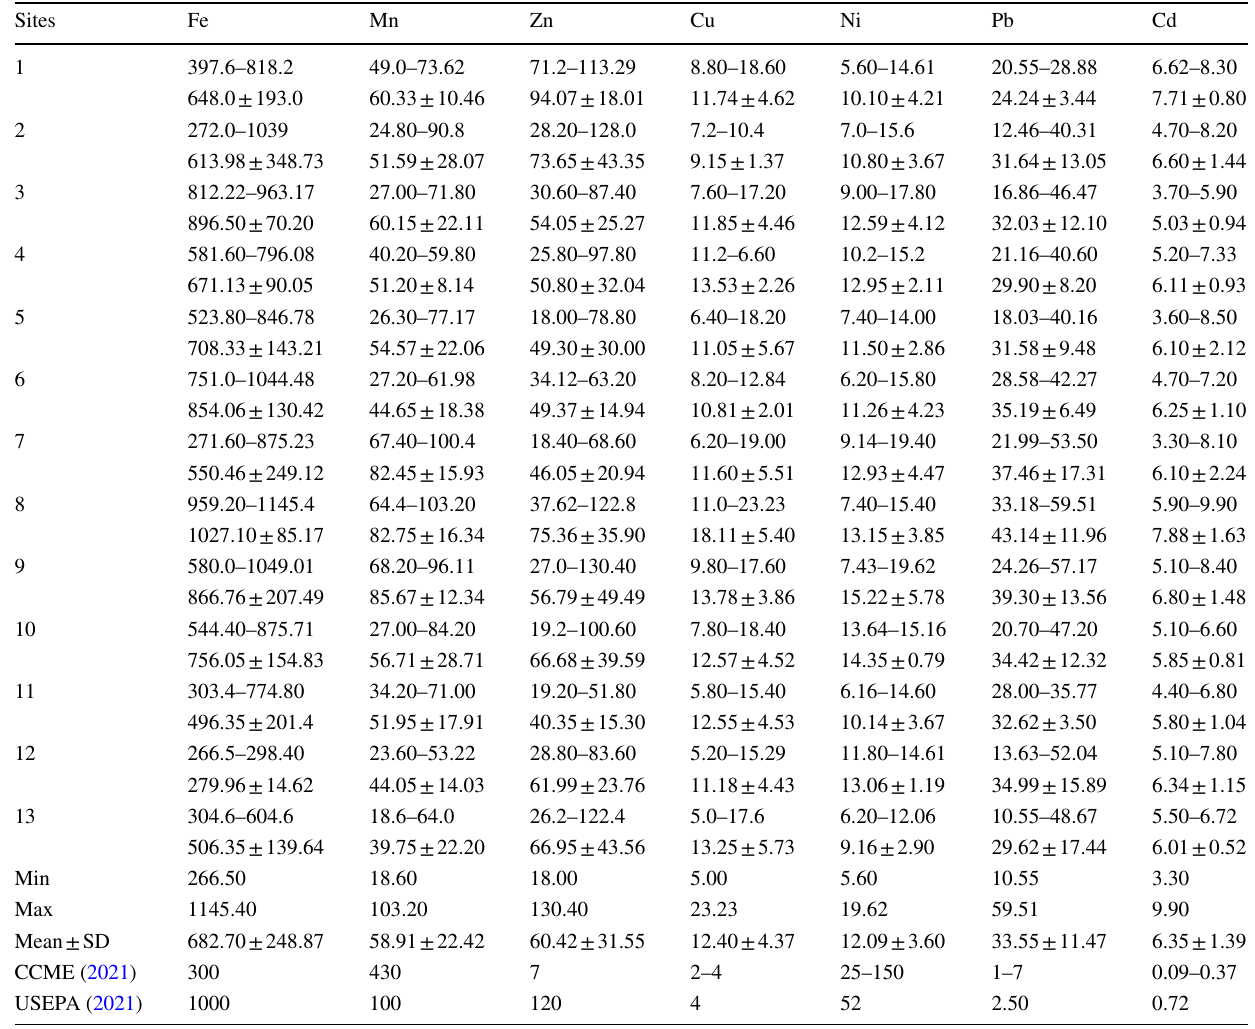
Table 3 Ranges, annual means, and standard deviations of heavy metals concentrations (μg/l) in Mariout Lake water compared to the standard permissible guidelines for aquatic life